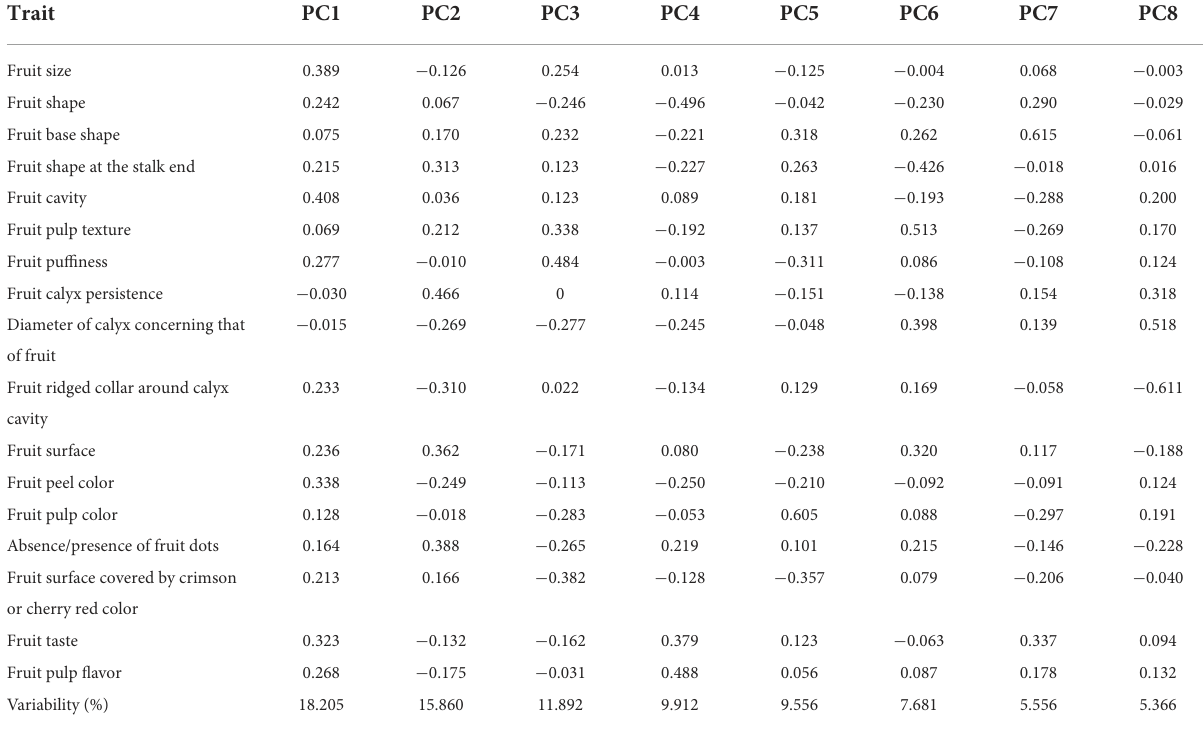
TABLE 3 First 8 components from the PCA analysis of 17 qualitative traits in 28 guava germplasm.